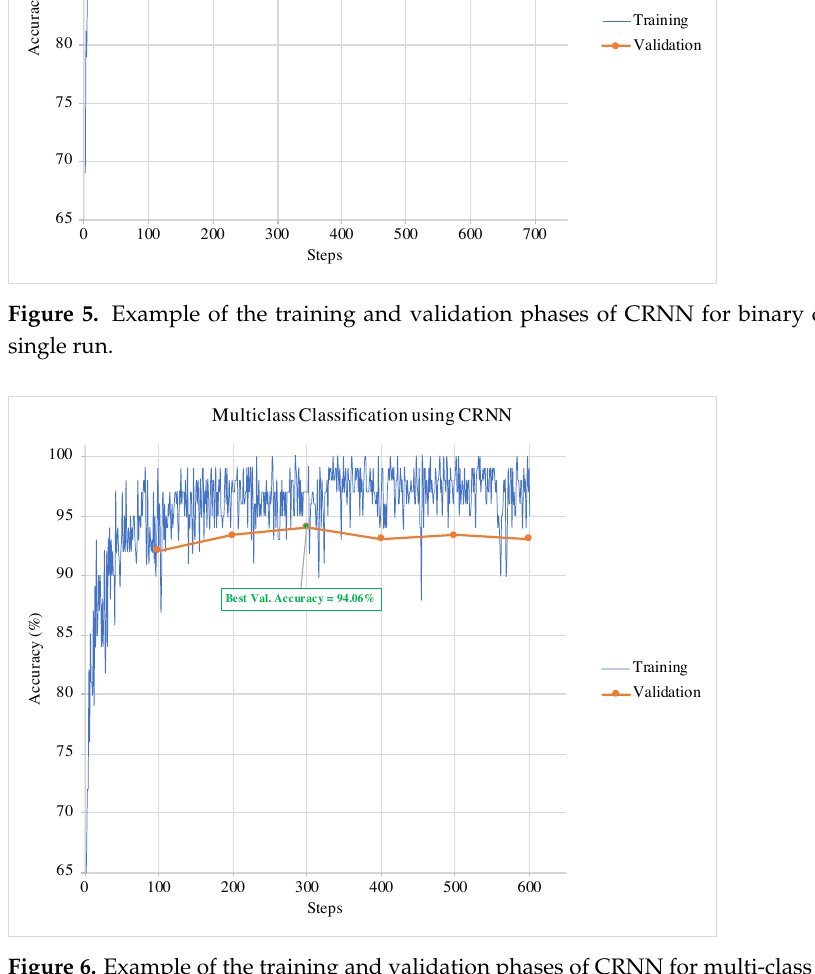
Figure 6. Example of the training and validation phases of CRNN for multi-class classification in a single run.